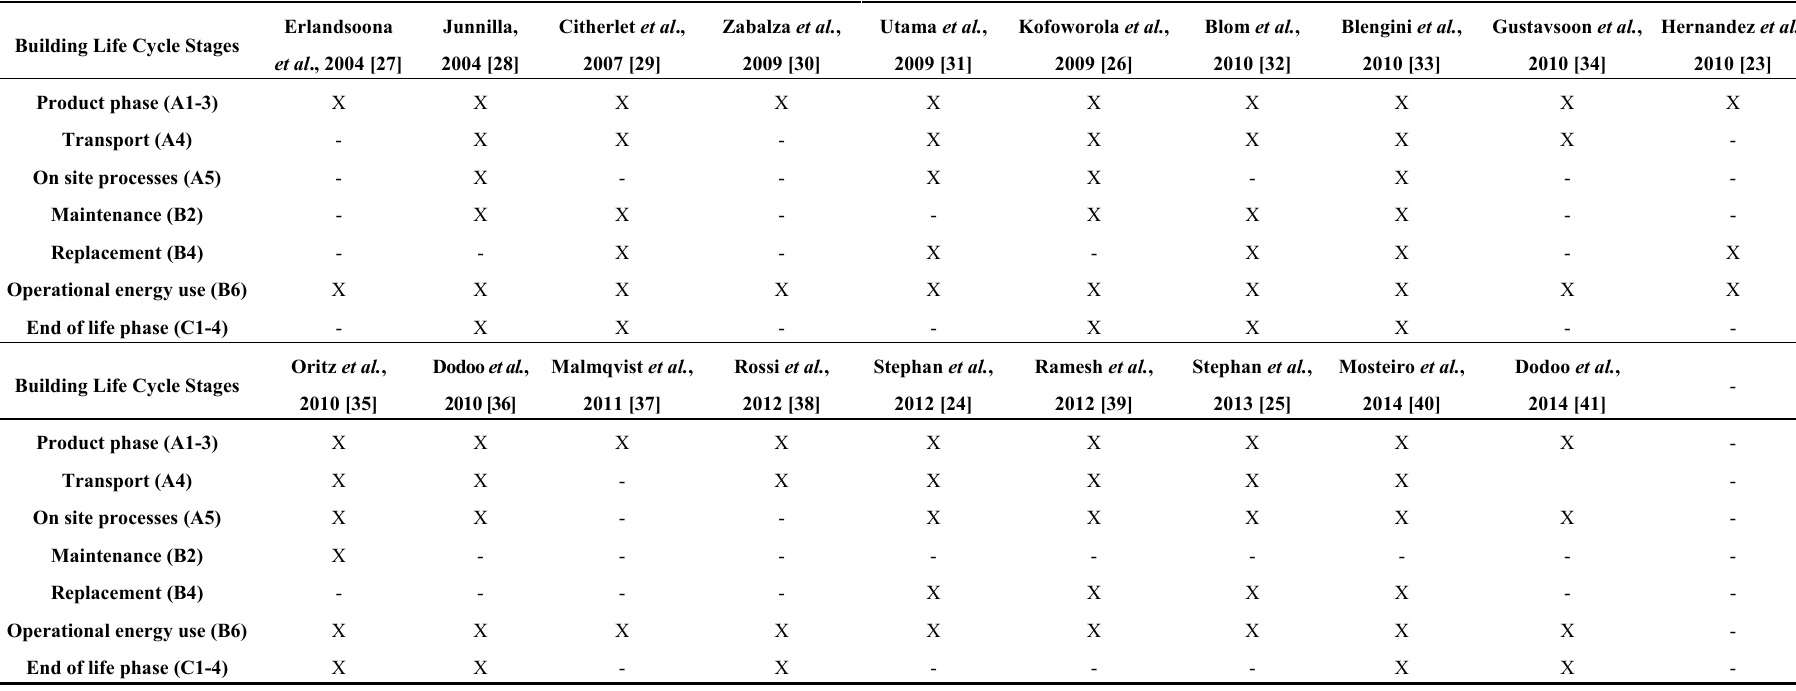
Table 1. Building Life Cycle Stages in relation to existing